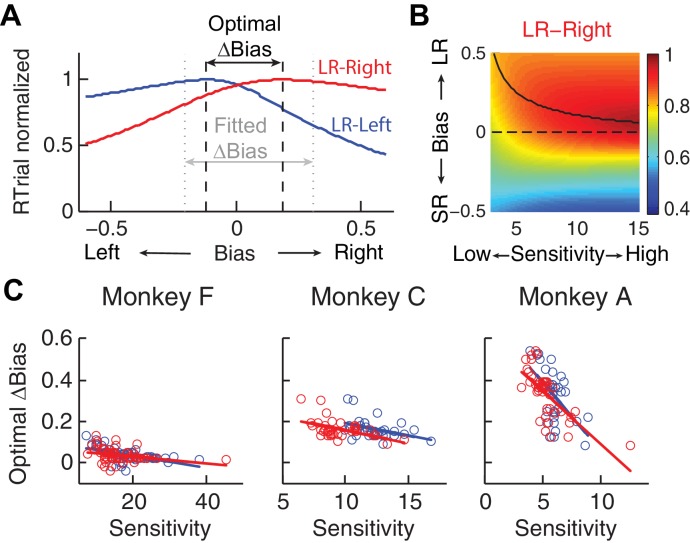
Relationship between bias and sensitivity. (A), Identification of the optimal Δbias for an example session using logistic fits.For each reward context (blue for LR-Left and red for LR-Right), RTrial was computed as a function of bias values sampled uniformly over a broad range, given the session-specific sensitivities, lapse rate, coherences, and large:small reward ratio. The optimal Δbias was defined as the difference between the bias values with the maximal RTrial for the two reward contexts. The fitted Δbias was defined as the difference between the fitted bias values for the two reward contexts. (B) The optimal bias decreases with increasing sensitivity. The example heatmap shows normalized RTrial as a function of sensitivity and bias values in the LR-Right blocks, assuming the same coherence levels as used for the monkeys and a large:small reward ratio of 2.3. The black curve indicates the optimal bias values for a given sensitivity value. (C) Scatterplots of optimal Δbiases obtained via the procedure described above as a function of sensitivity for each of the two reward contexts. Same format as Figure 2C Solid lines indicate significant partial Spearman correlation after accounting for changes in reward ratio across sessions (p<0.05). Note that the scatterplots of the monkeys’ Δbiases and sensitivities in Figure 2C also show negative correlations, similar to this pattern.